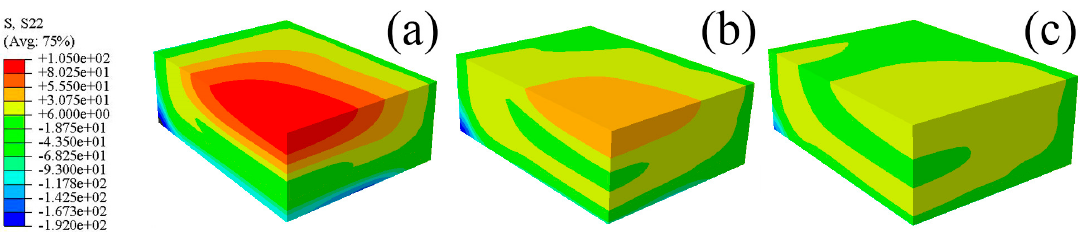
Figure 12. Predicted residual stresses contours of the 1/8 model for the S11 component; ( a ) 20 °C; ( b ) 40 °C; ( c ) 60 °C.